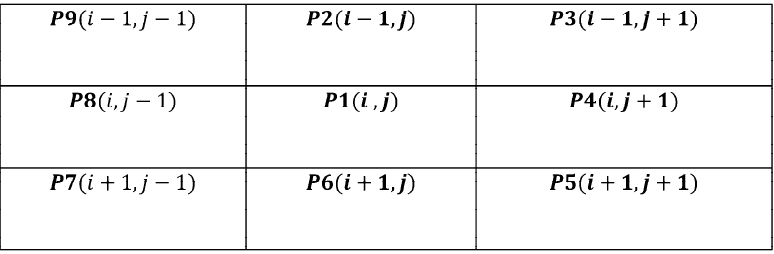
Figure 3. Designations of the pixels in a 3 × 3 window.